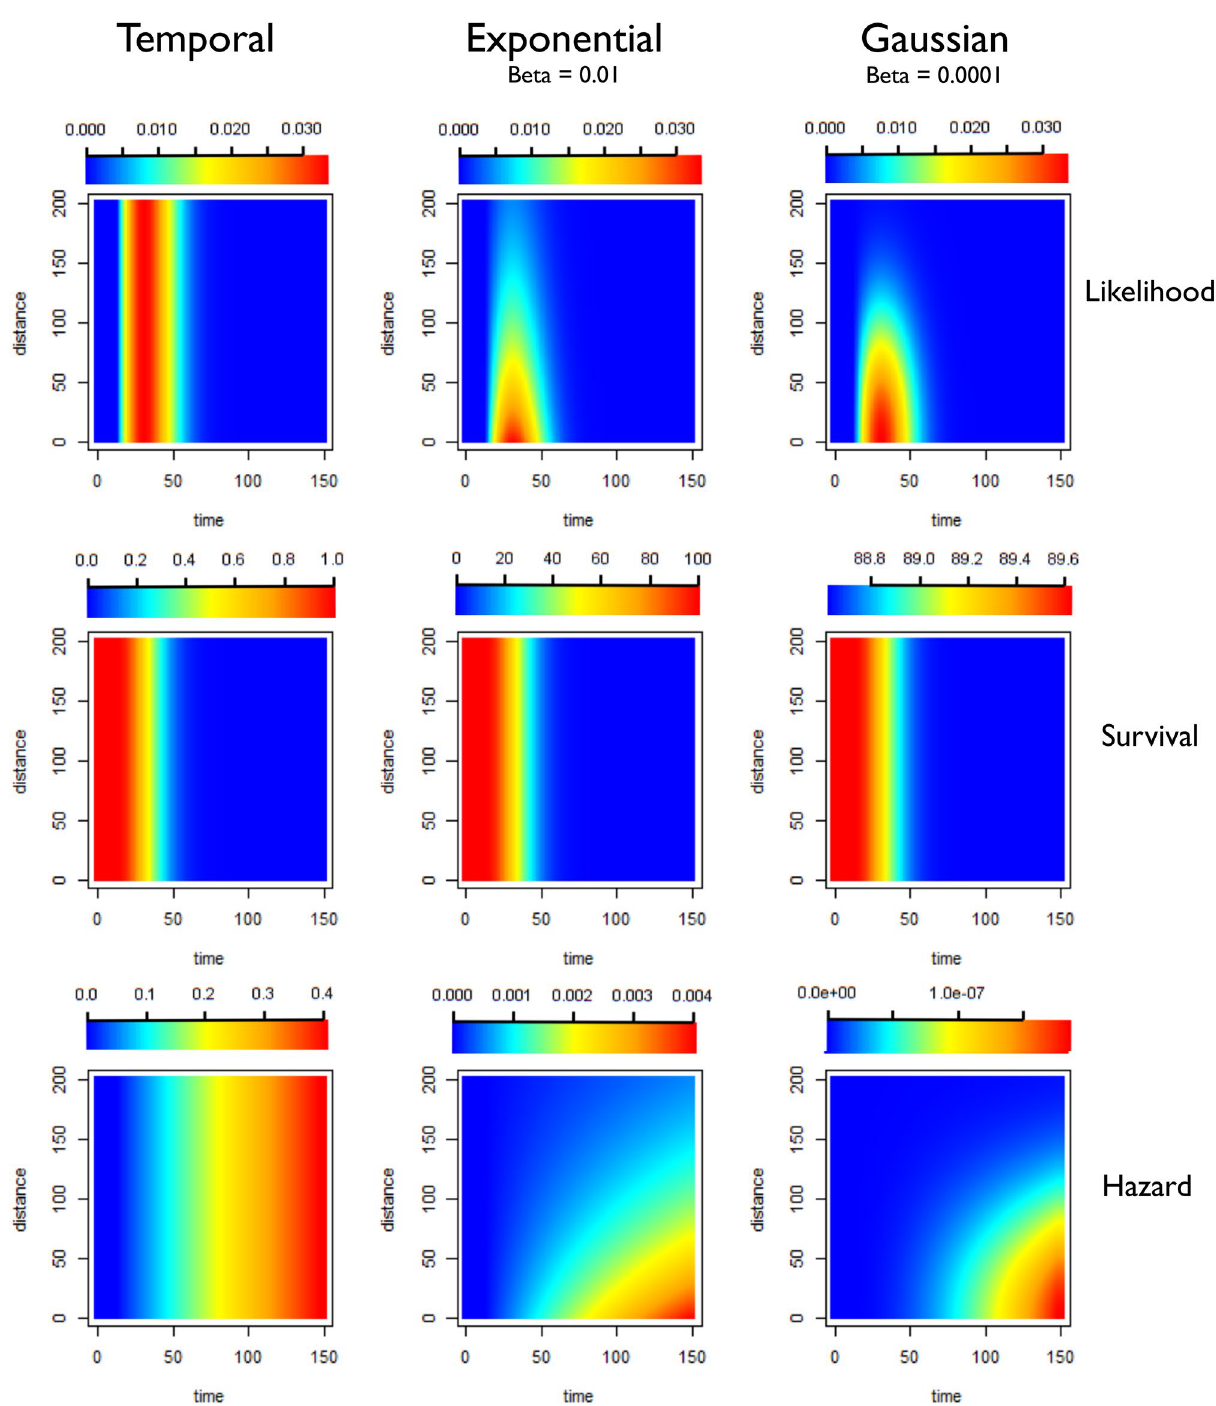
Figure 13. Illustration of likelihoods, hazards and survivals for less restrictive kernels (longer range human movement likely). Plots showing how the pairwise likelihoods, survivals and hazards vary with time and distance under different model structures. The first row of plots shows the pairwise likelihoods, the second row shows the pairwise survival and the third row shows the pairwise hazard values for different combinations of distance (in kilometres) and time between symptom onset (days). The first column shows the results for a time- only version of the algorithm. The second column shows results for an exponential kernel and the third column shows results for a Gaussian kernel. In this example less restrictive values for beta, the shaping parameter for the distance kernels have been chosen, representing a context where there is more long-range movement of